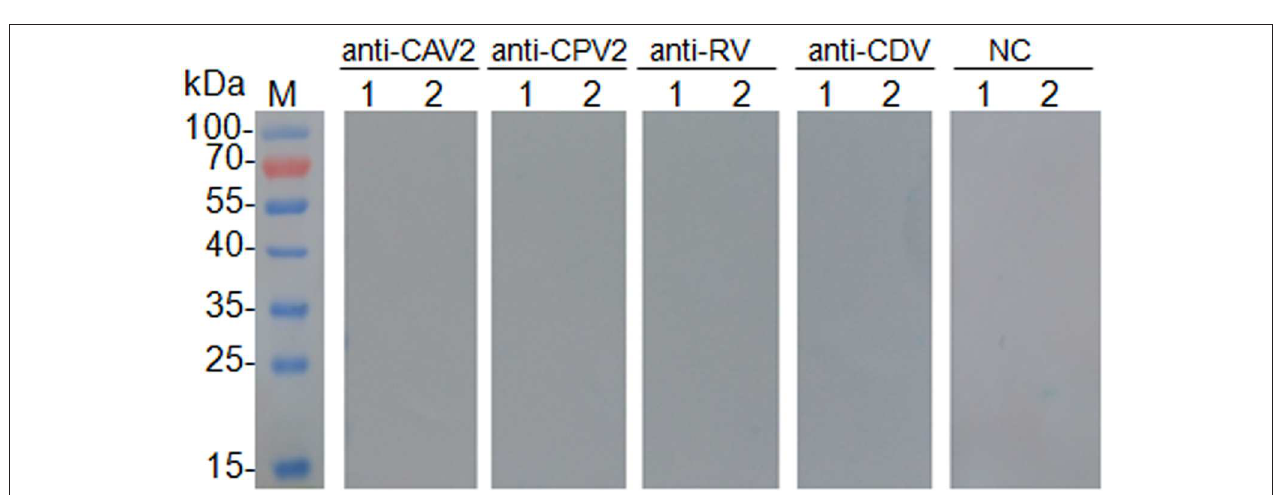
FIGURE 2 | Results of cross test of Western blot was performed with canine adenovirus type 2 positive sera (anti-CAV2), canine parvovirus positive sera (anti-CPV2), rabies virus positive sera (anti-RV), canine distemper virus positive sera (anti-CDV), and CanineCV negative sera control (NC). Lane M, protein molecular weight marker; Lane 1, pET-32a vector control; Lane 2, purified protein